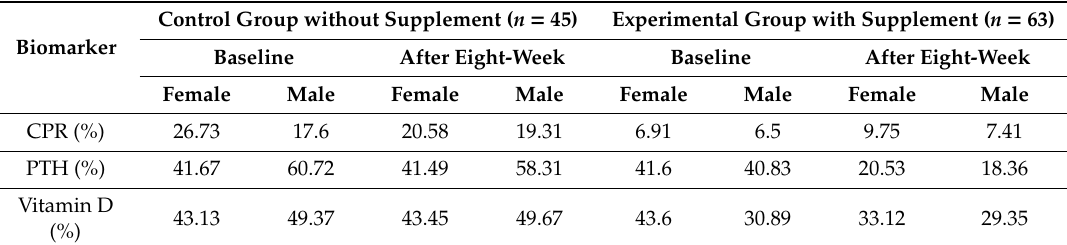
Table 3. Analysis of coe ffi cient of variance of control and experimental groups.